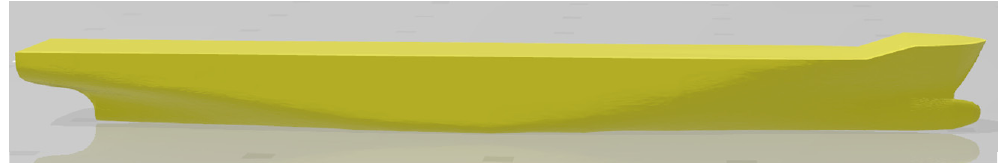
Figure 5. Three-dimensional geometric model of 6750TEU container ship. Table 1. Principal dimensions of the 6750-TEU container ship.